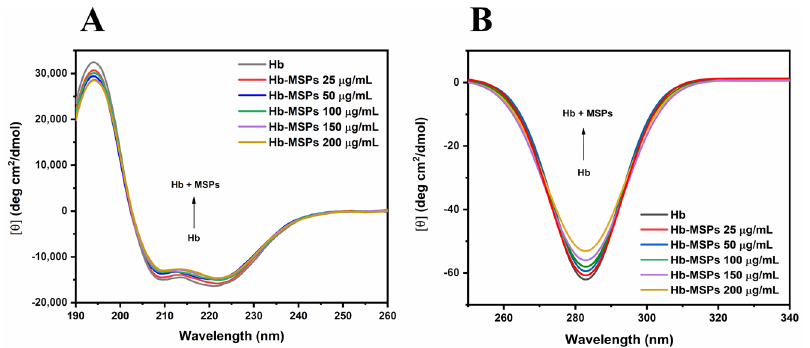
Figure 6. Far − UV ( A ) and near-UV ( B ) circular dichroism spectra of Hb and Hb − MSPs at different MSP concentrations (25, 50, 100, 150, 200 µg/mL; bottom to top) and at Hb concentrations of 0.1 mg/mL ( A ) and 1 mg/mL ( B ). 0.1 mg/mL ( A ) and 1 mg/mL ( B